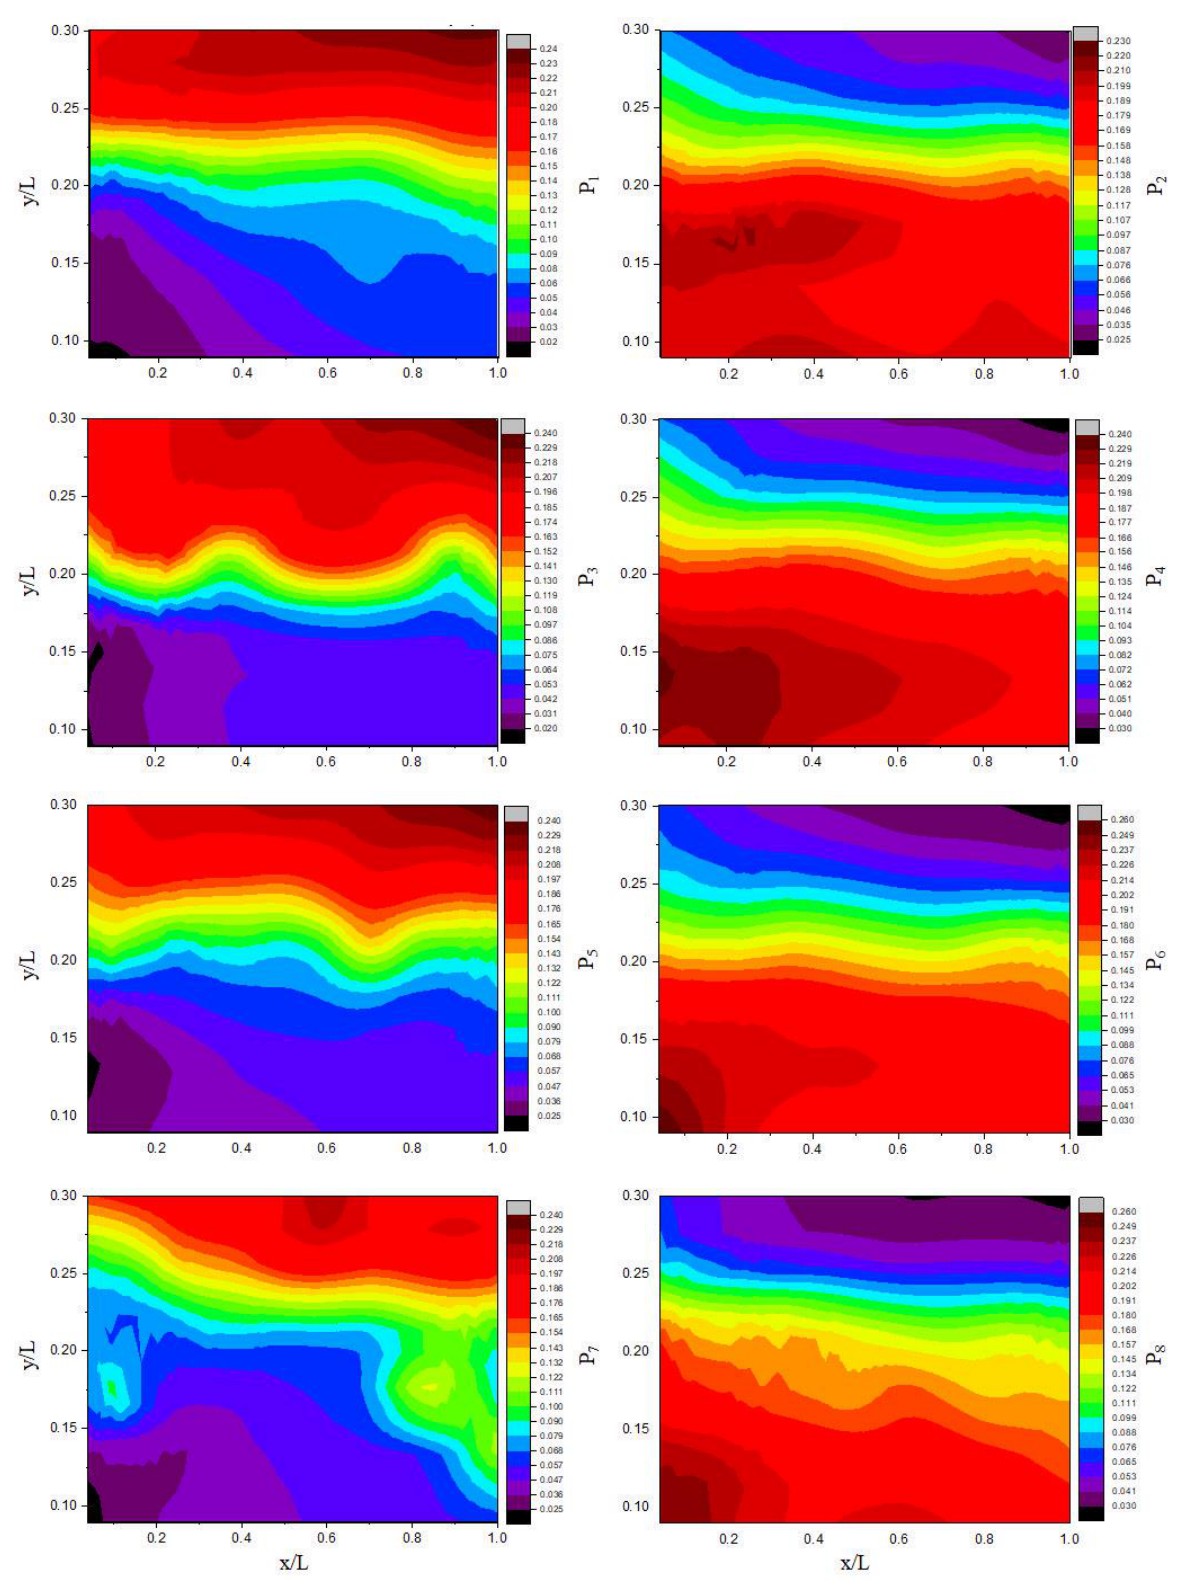
Figure 10. Contours maps of depth-averaged occurrence probability of octagonal bursting events (P 1 –P 8 ) for the experimental run 6R.